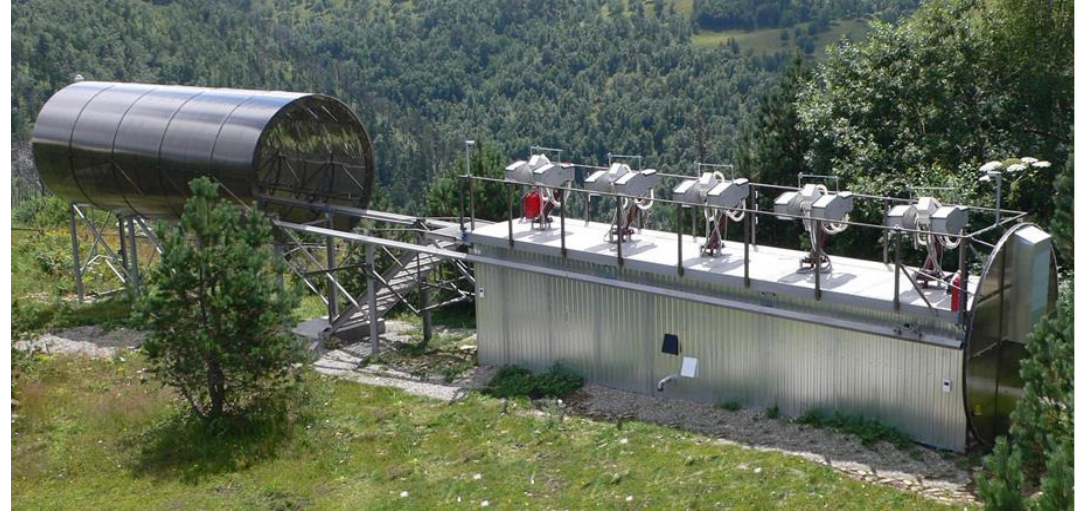
Figure 3. General view of the assembled entire Mini-MegaTORTORA